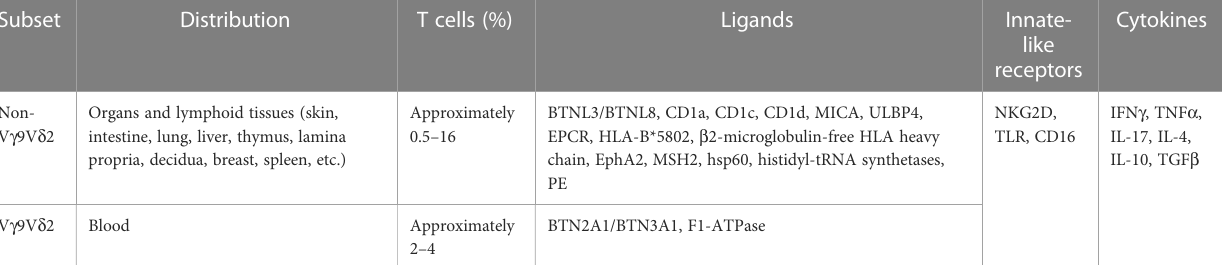
Organs and lymphoid tissues (skin, intestine, lung, liver, thymus, lamina propria, decidua, breast, spleen,